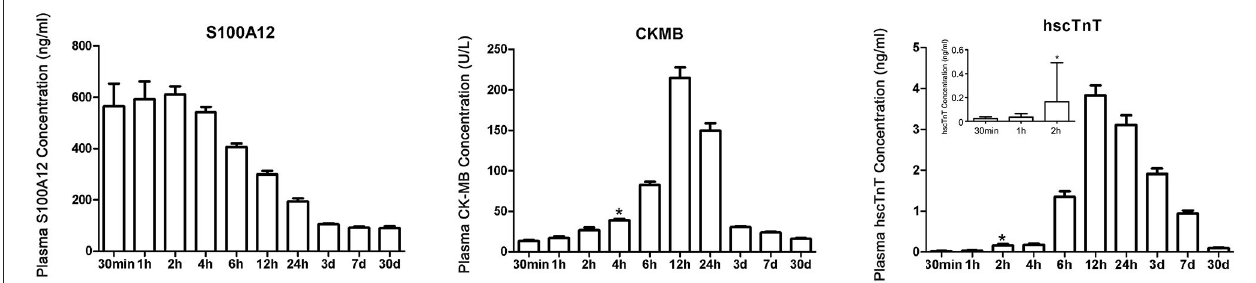
FIGURE 2 | Time trends of plasma S100A12, CK-MB and hscTnT levels in patients with STEMI. *Represents the time point when plasma concentration was first higher than the diagnostic critical value. Chest pain time ≤ 30min included 9 STEMI patients (a total of 9 samples were measured); chest pain time of 30min to 1h included 28 STEMI patients (a total of 37 samples were measured); and chest pain time of 1–2h included 113 STEMI patients (a total of 150 samples were measured). Samples from all 150 patients were tested at each subsequent time after 2h. Bars and limit lines represent the mean ± SEM.